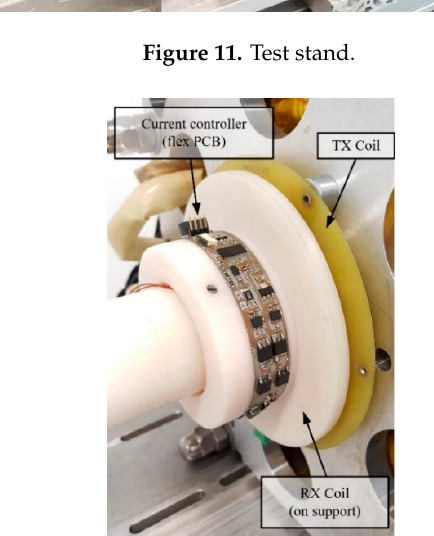
Table 2. Comparison of 3D-FEA predictions and experimental results of no-load back-emf Figure 13. Basic waveforms for serial resonant operation ( I DC = 1 A): measurements; ( a ) simulation results; ( b ) top waveforms: Output voltage from inverter, bottom: Current from inverter.